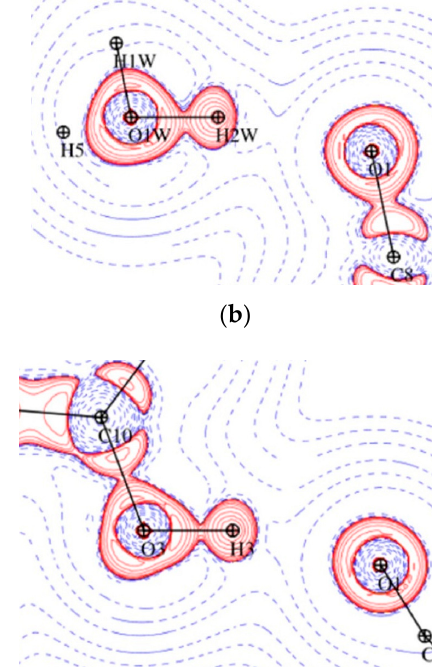
Figure 9. OH···O interaction, bond path and associated critical point in 1 ( left ) and 2 ( right ).